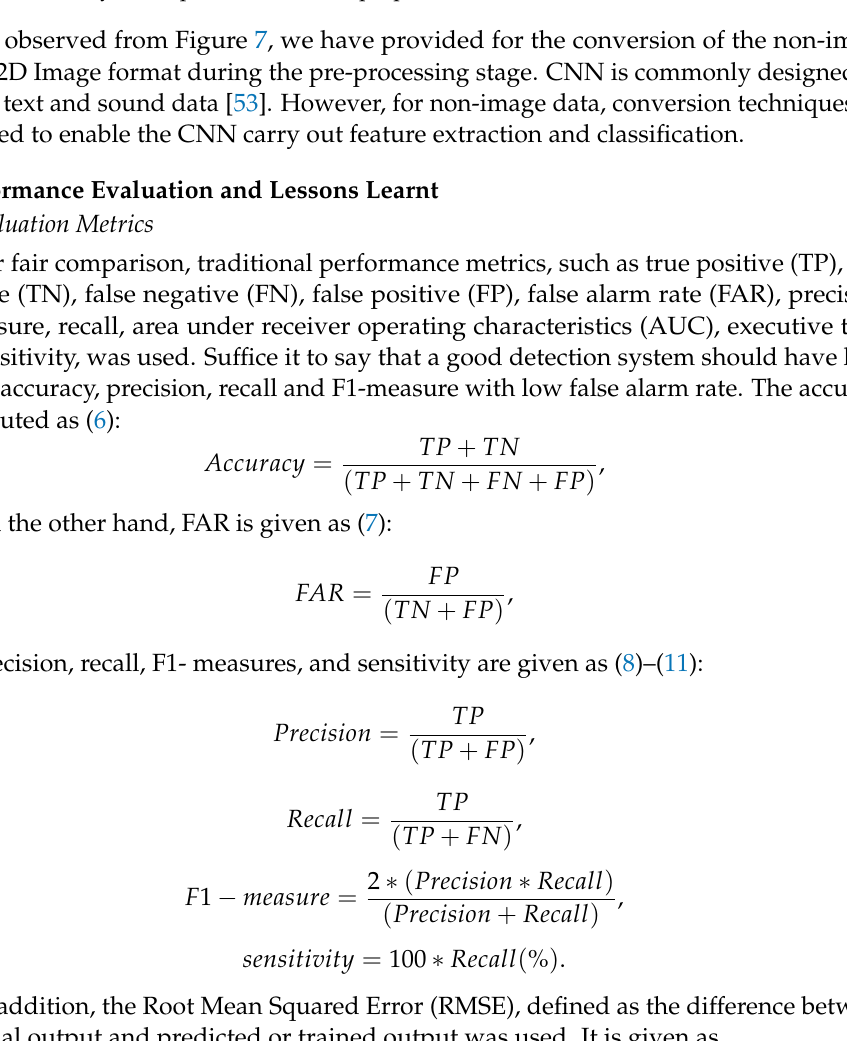
Figure 9. Summary of the parameters of the proposed